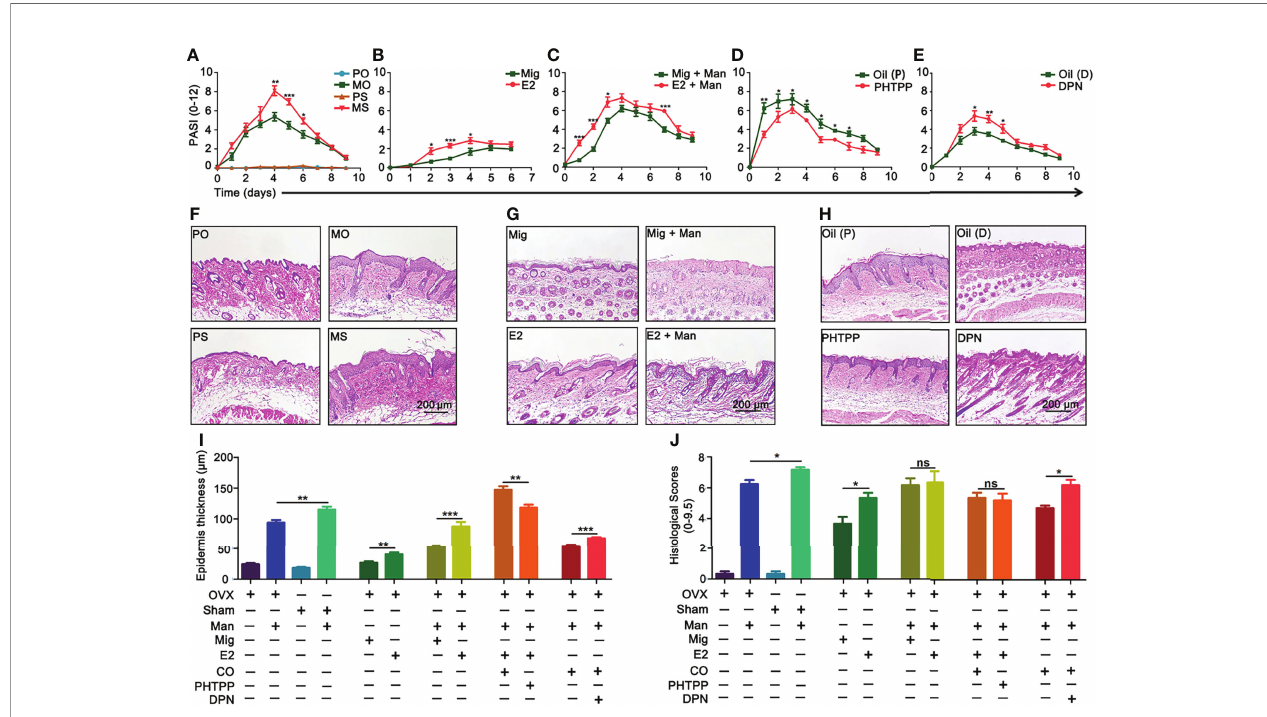
FIGURE 3 | Endogenous and exogenous estrogen promoted psoriasis. Comparison of psoriasis scores (PASI): (A) Ovariectomized (OVX) and sham operated mice with or without mannan application (n = 10/group); (B) single 17- b -estradiol or miglyol alone treated mice without any mannan application (n = 10/group); (C) 17- b -estradiol or miglyol alone injected mice with mannan application (n = 10/group); (D) ER- b antagonist (PHTPP) or corn oil alone treated mice (n = 5/group), (E) ER- b agonist (DPN) or corn oil alone treated mice (n = 5/group). Representative pictures of H&E-stained skin samples at peak of psoriasis from (F) OVX and sham operated mice, (G) 17- b -estradiol treated OVX mice, without and with mannan stimulation, and (H) after PHTPP and DPN treatment. (I, J) Epidermis thickness (n = 5/group) and histological scores of skin sections (n = 3/ group) at Day 5 were calculated from Figures (F – H) . Scale bar: 200 µm. Each experiment was repeated twice. Statistical analyses were performed using an unpaired t test and n indicates number of mice. The data represent mean ± SEM. Man, mannan; PO, PBS + OVX; MO, Man + OVX; PS, PBS + sham; MS, Man + Sham; Mig, miglyol; E2, 17- b -estradiol; Oil (P), E2 + Corn Oil + Man; PHTPP, E2 + PHTPP + Man; Oil (D), Corn Oil + Man; DPN, DPN + Man. The data represent mean ± SEM. ns, not signi fi cant. *p < 0.05; **p < 0.01. ***p <